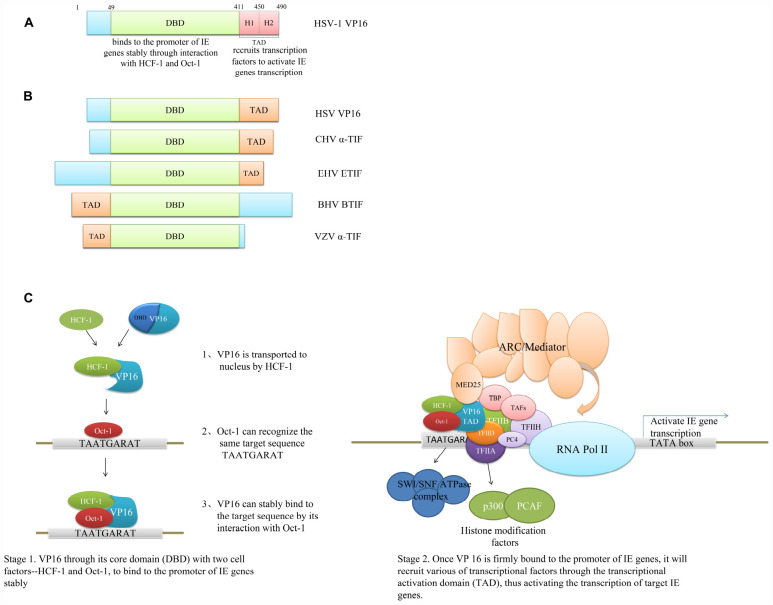
Domain structure and mechanism of VP16 to promote IE gene transcription. (A) Domain structure of HSV-1 VP16. The DBD can bind to the promoter of IE genes stably through interaction with HCF-1 and Oct-1, and the TAD of HSV VP16 can be divided into two regions, H1 and H2, which can bind to different transcriptional activators and also synergistically interact with some important transcriptional factors (Ikeda et al., 2002; Hirai et al., 2010). (B) The schematic of various VP16 homologs with their functional domains. The DBD is conserved in VP16 homologs, but the TADs of VP16 homologs are not conserved in position, sequence, or amino acid properties. The VP16 TAD of HSV and EHV is located at the C-terminus, but in BHV and VZV, the VP16 TAD is located at the N-terminus (Cohen and Seidel, 1994; Wysocka and Herr, 2003; Tyack et al., 2006). (C) Mechanism of VP16 to promote IE gene transcription. The DNA-binding ability of VP16 itself is weak, and the binding is unstable; VP16 mainly combines with HCF-1 and Oct-1 to form a complex through the unstructured region in its DBD, so as to bind stably to the specific site of the target gene promoter and then recruit transcriptional factors through the TAD to promote the transcription of the target gene. The formation of the complex by VP16, HCF-1, and Oct-1 is the most effective combination by VP16 dominated to activate viral gene cascade expression. The VP16-induced complex represents a regulatory switch for two modes of viral infection: lytic infection and latent infection. When it is “on,” it promotes the transcription of IE genes and thus lytic infection, and when it is “off,” limiting IE gene transcription, viruses can maintain established latent infections (Wysocka and Herr, 2003; Hirai et al., 2010; Milbradt et al., 2011).